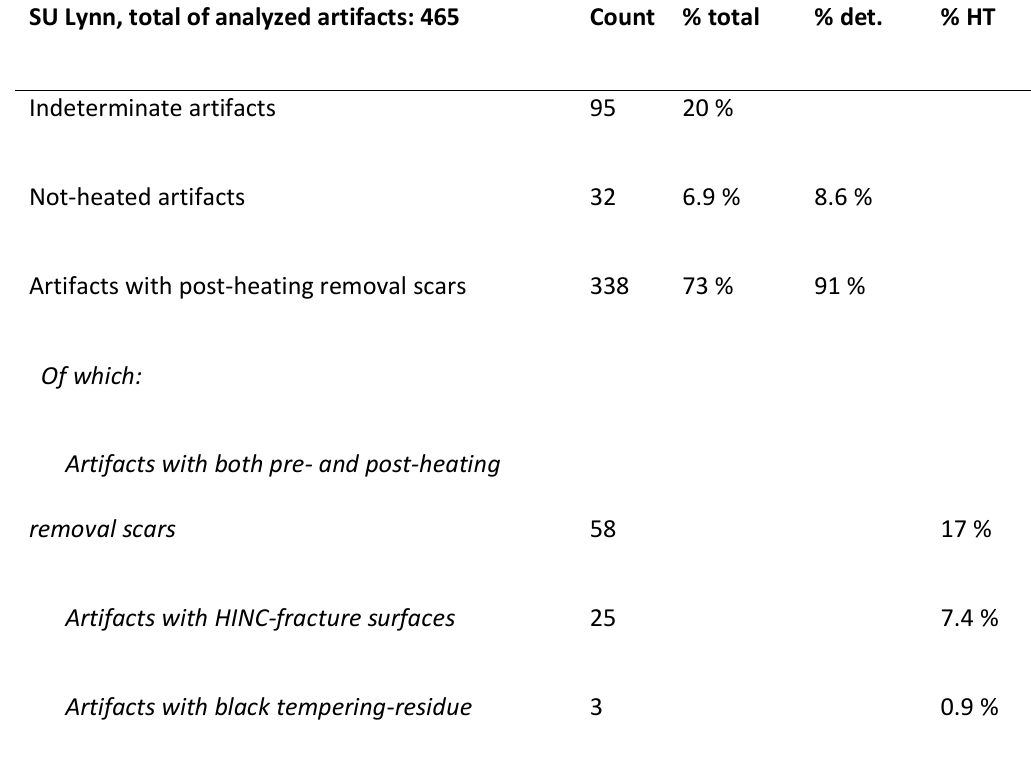
Table 2 . Results of the analysis of the silcrete artifacts from the stratigraphic unit Lynn at Diepkloof Rock Shelter. Percent ages under ‘% total’ refer to the total of analyzed artefacts in the stratigraphic unit, percentages under ‘% det.’ refer to all determinable artifacts in the given stratigraphic unit but exclude non- diagnostic artefacts. Percentages under ‘% HT’ refer to the number of heat-treated artifacts in the stratigraphic